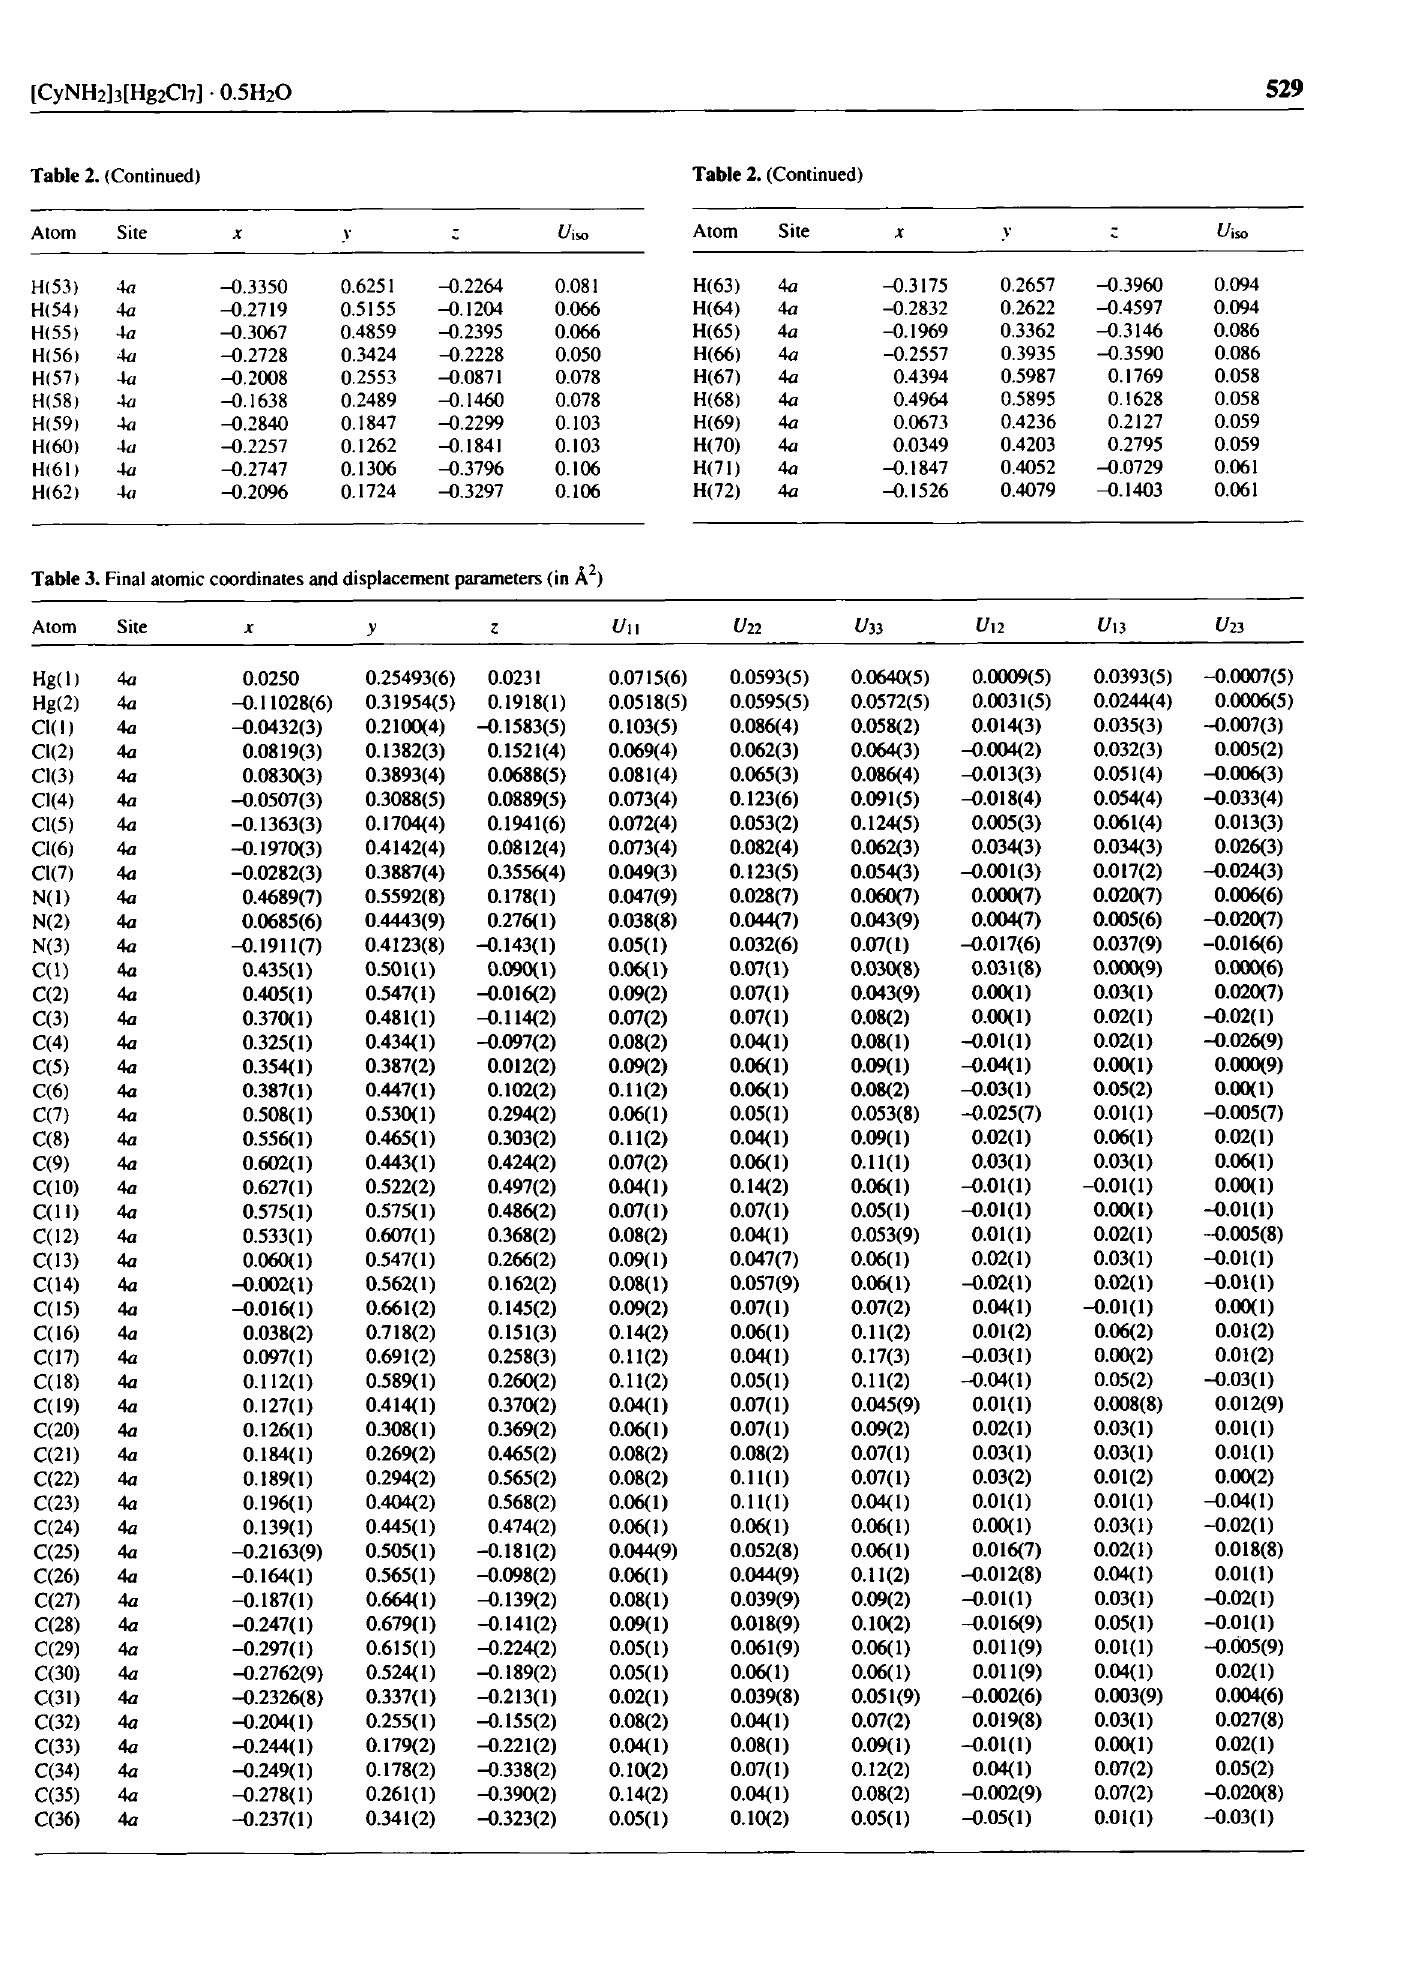
Table 3. Final atomic coordinates and displacement parameters (in